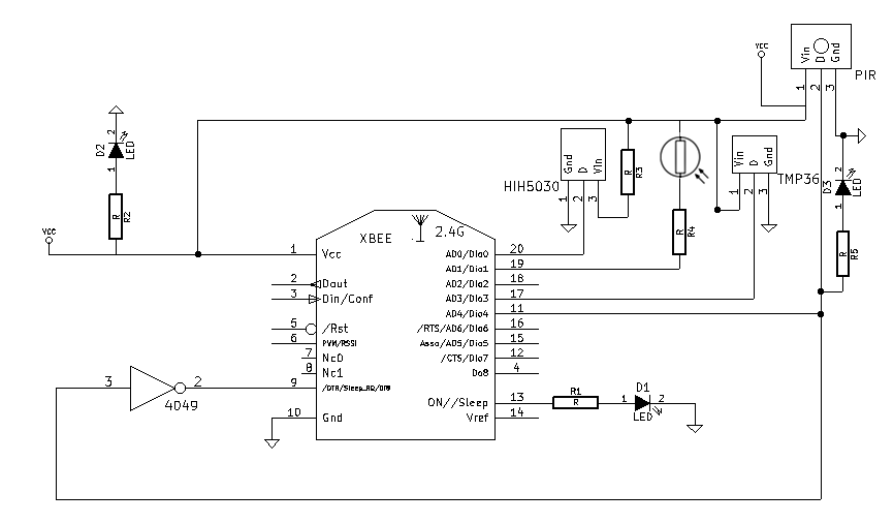
Figure 8. Schematic of the sensor